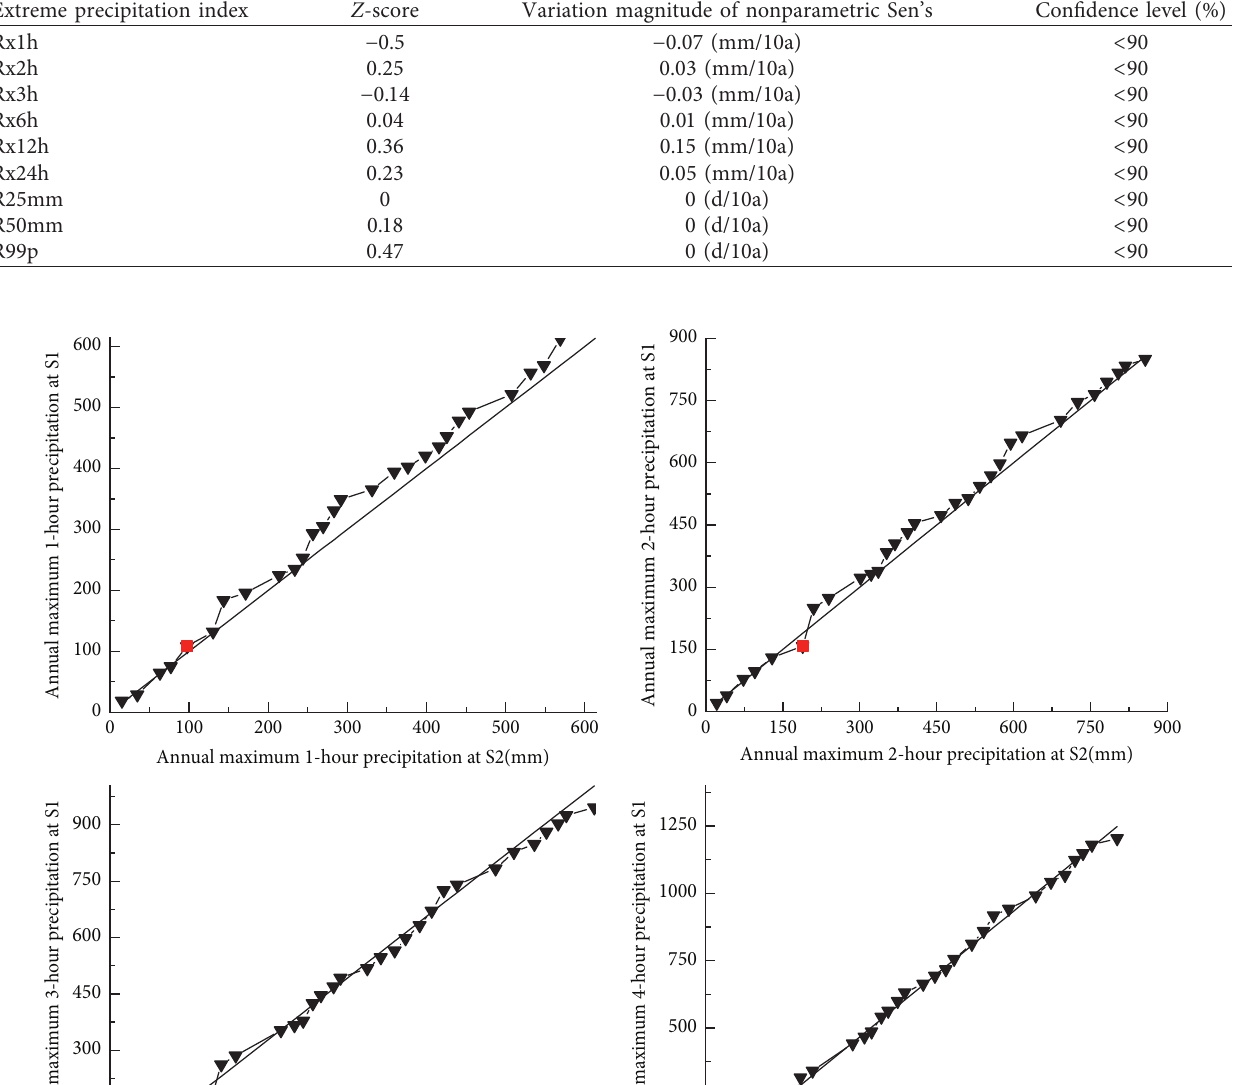
Table 4: MK tests and slopes of indices of extreme precipitation in the rural area of the study area.